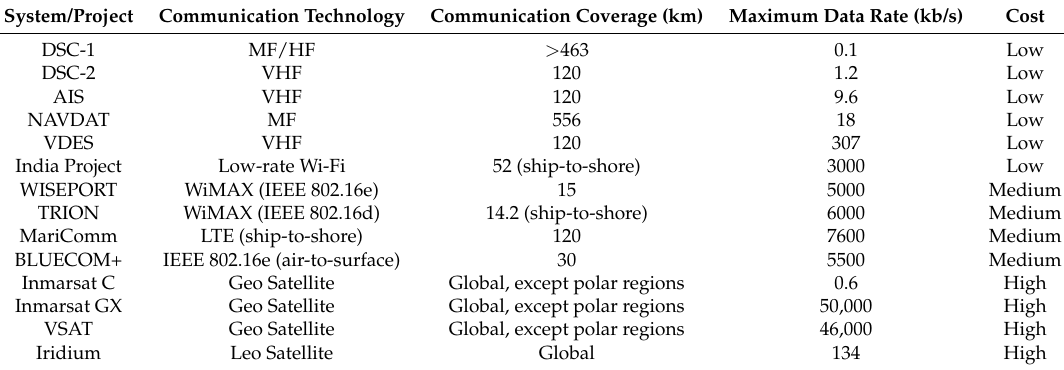
Table 3. A summary of maritime wireless communication project characteristics [48].